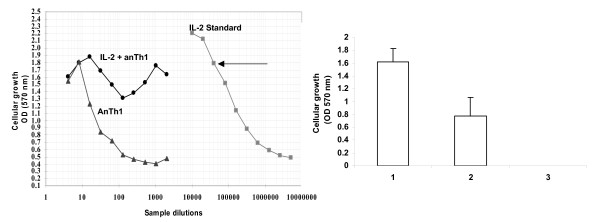
IL-2 antagonistic/agonistic biological activities of the recombinant chimeric protein. Panel A: Antagonistic/agonistic biological activities. The figure shows plots of a representative CTLL-2 proliferative assay showing the OD of tested samples in each of the evaluated serial dilutions. The IL-2 used for the experiments is the IL-2 international standard (ST-IL-22010397, 880 000 UI/mL). The arrow shows the OD of IL-2 dilution to test in the presence of serial dilutions of recombinant protein. Panel B: Stimulation of T cells proliferation by TH1 antagonist. Bar 1: 2.8 ng/ml of IL-2 (dilution 1:40000), bar 2: 1.5 μg/ml of AnTH1, bar 3: culture medium without IL-2.